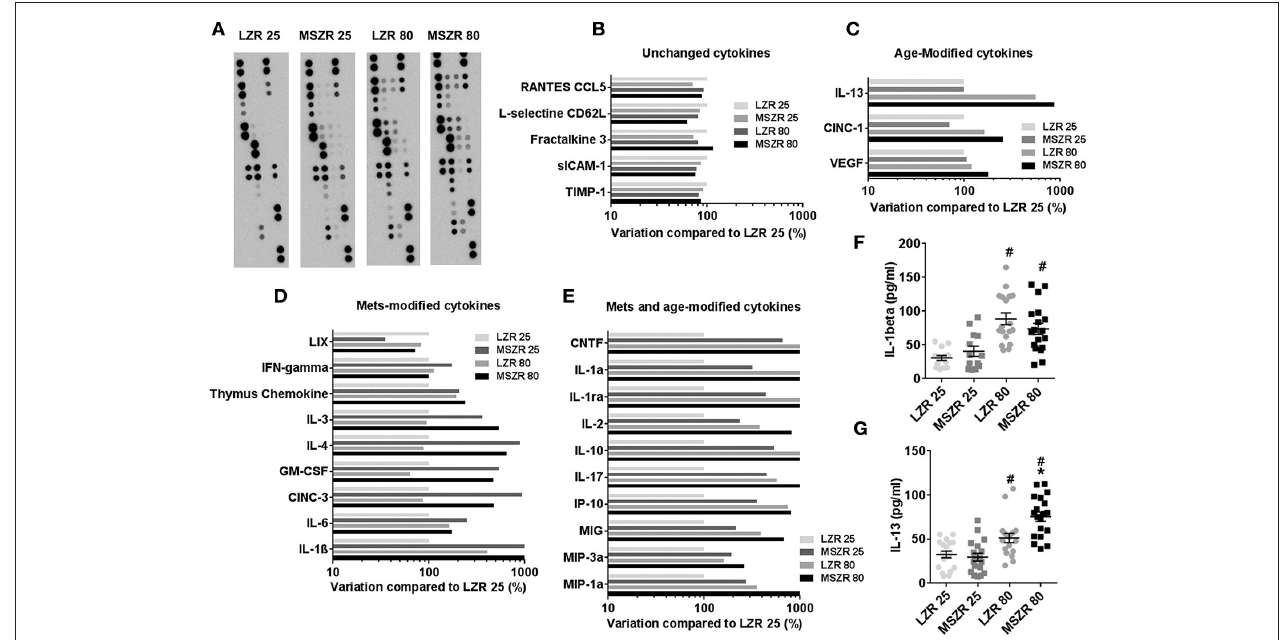
FIGURE 3 | Plasma cytokine array in Zucker rats . (A) Cytokine arrays of pooled platelet free plasma from 25 to 80 week-old MSZR and LZR. Relative chemoluminescence compared to 25 week-old LZR was measured. (B) Unchanged cytokines, (C) cytokines modified with age, (D) with MetS, or (E) both with MetS and age. ELISAs results for IL-1 β (F) and IL-13 (G) measured in PFP ( n = 14–18), results are mean ± standard error of the mean, * p < 0.05 vs. LZR at the same age; # p < 0.05 vs. 25 week-old rats in the same strain. VEGF, vascular endothelial growth factor; CINC-1, cytokine-induced neutrophil chemoattractant 1; CINC-3, cytokine-induced neutrophil chemoattractant 3; GM-CSF, granulocyte macrophage colony stimulating factor; MIP, Macrophage Inflammatory Protein; MIG, C-X-C motif ligand 9; IP-10, interferon gamma-induced protein 10; CNTF, ciliary neurotrophic factor; INF γ , interferon γ ; IL,